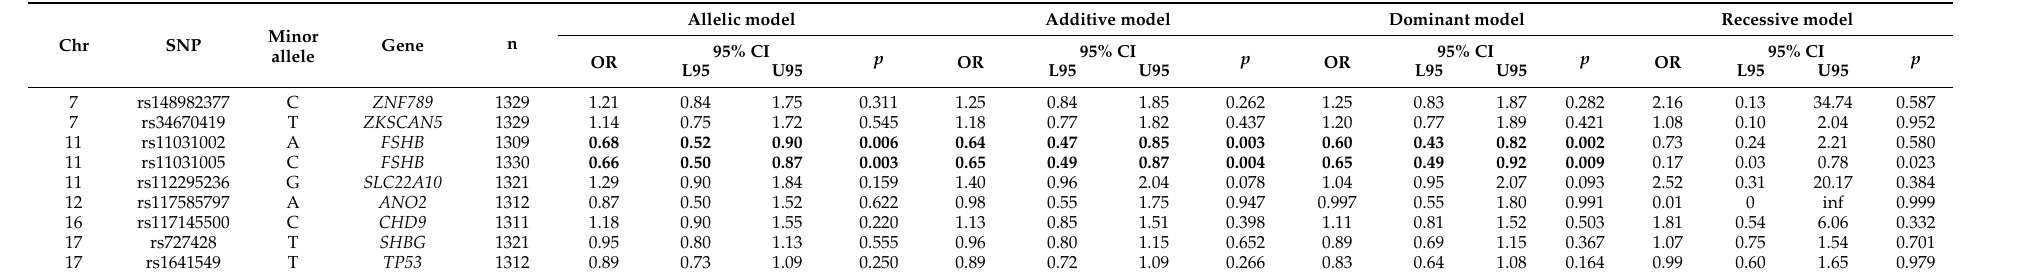
Table 1. Associations of the studied gene polymorphisms with